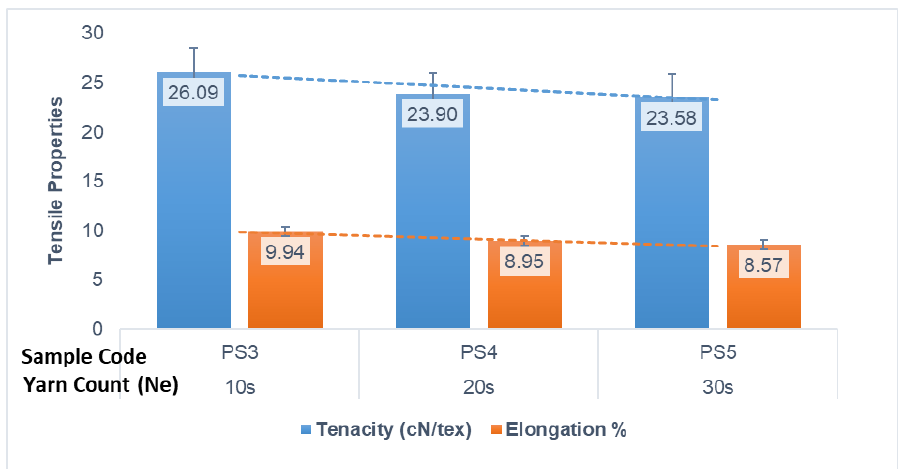
Figure 3. Effect of yarn count on tensile properties of conventional ring-spun MFHSYs.